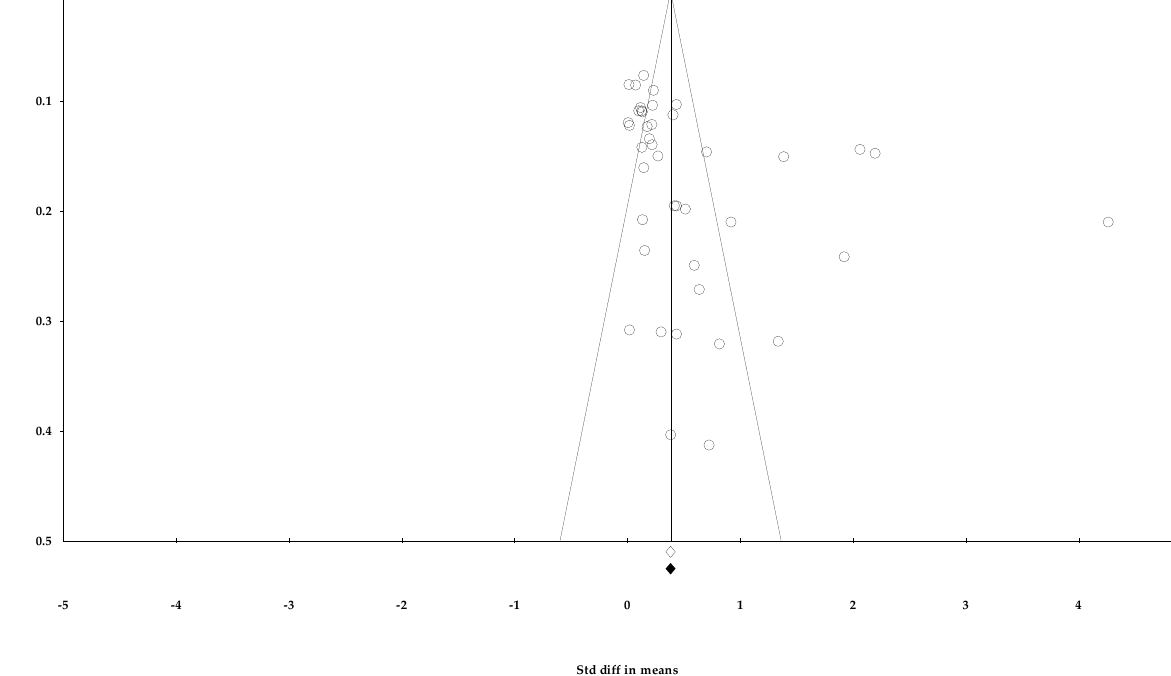
Figure 3. A funnel plot of standardized mean difference in diastolic blood pressure. Note: summary effect size ( ◇ ), sum- mary effect size of imputed studies ( ◆ ), individual study ( ○